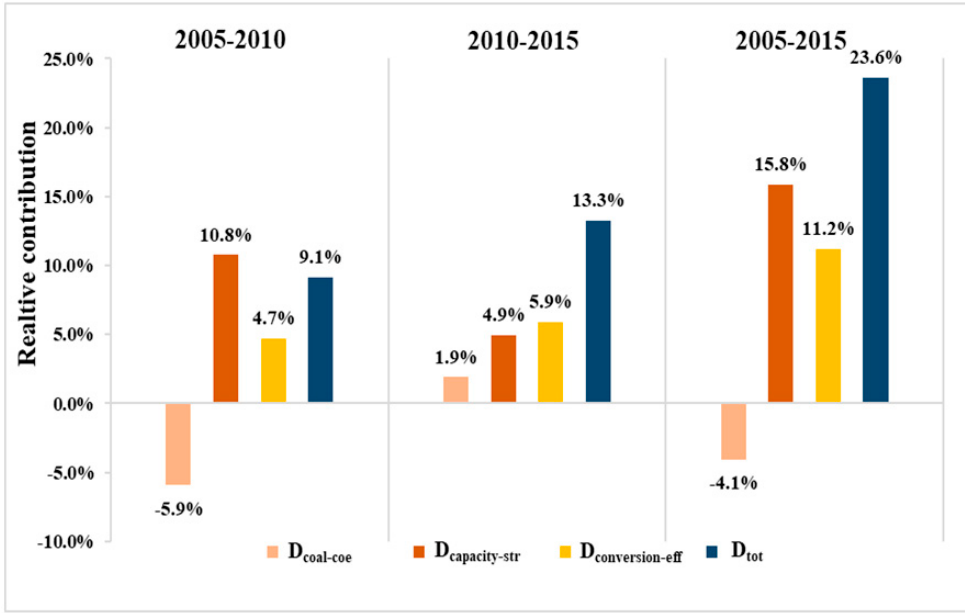
Figure 13. Relative contributions of driving factors of industrial coal boiler in China from 2005 to 2015.